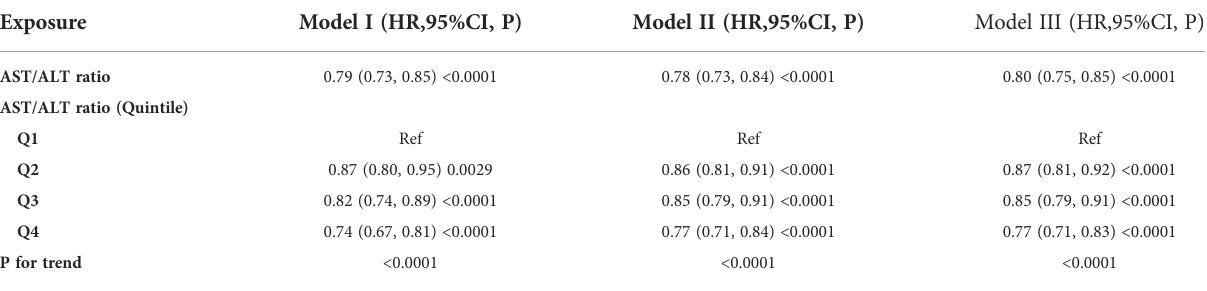
TABLE 5 Relationship between AST/ALT ratio and prediabetes in different sensitivity